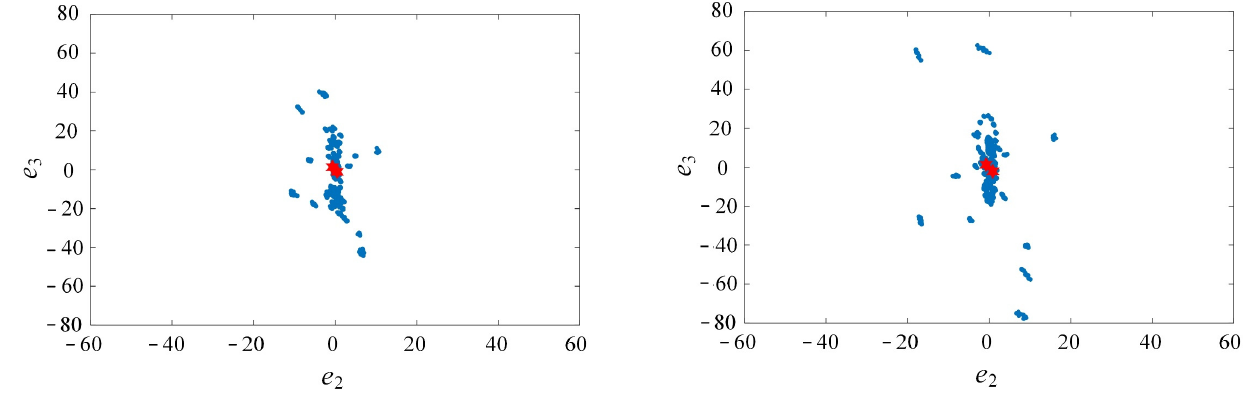
Figure 19. Normalized chaotic dynamic error map ( e 2 e 3 ) of PV module fault types.